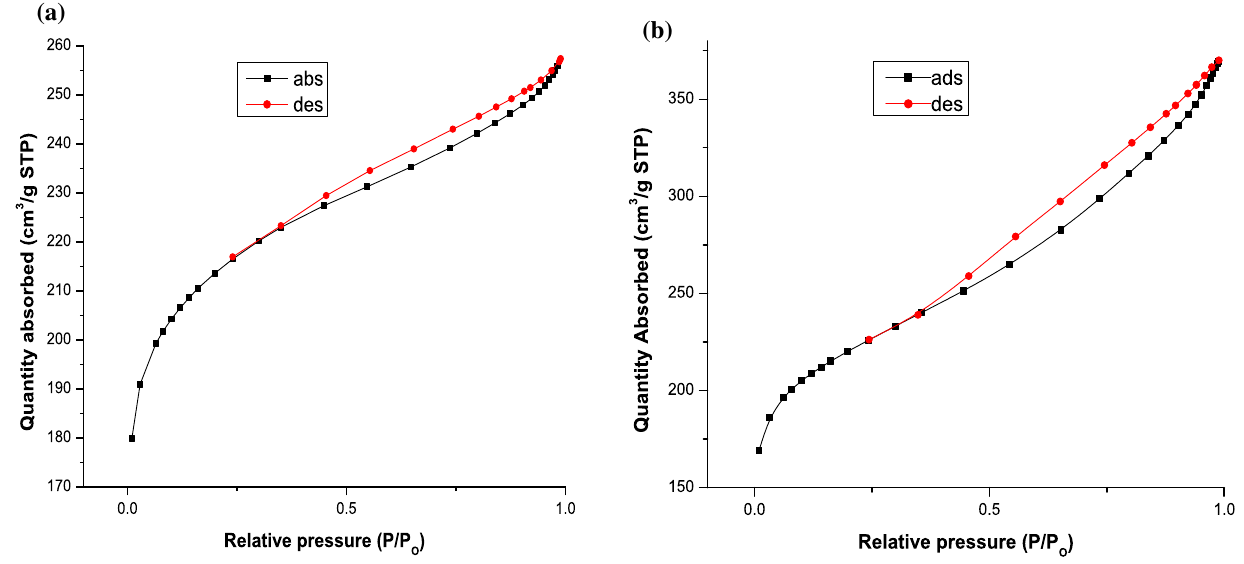
Fig. 4 N 2 adsorption–desorption isotherm for a AWS (before activation) and b KOHAWS (after activation)